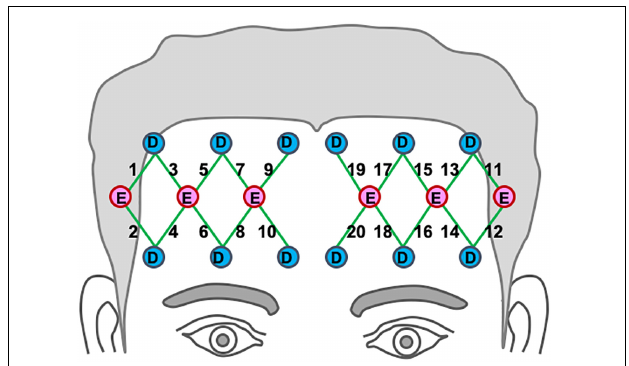
FIGURE 2 | Location of optodes across the participants’ bilateral prefrontal cortex. Detectors are marked as “D” in blue circles, and emitters are marked “E” in red circles. Channel paths are represented in the 20 green lines (Berglund-Barraza et al.,